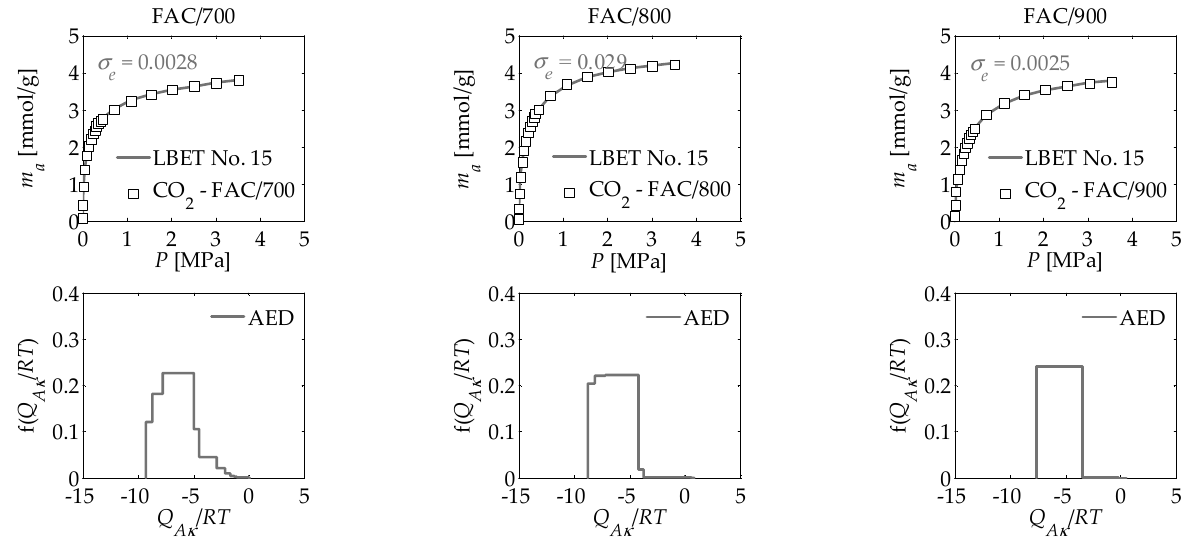
Figure 5. Carbon dioxide adsorption isotherms for activated carbons derived from the leaves of common polypody and the fast multivariant identification procedure results obtained via the LBET method, where AED is the adsorption energy distribution for the first ad-